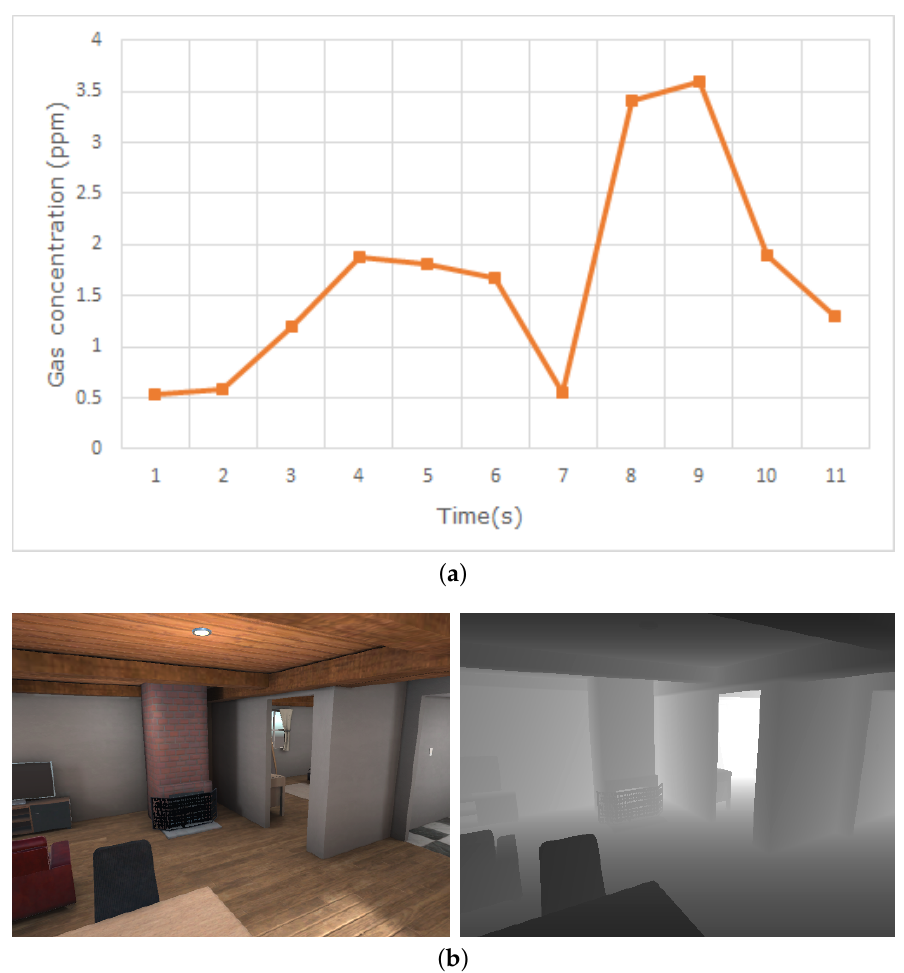
Figure 4. ( a ) Measurements obtained with a simulated photoionization detector at a given point over time. ( b ) RGB and depth images obtained from Unity’s simulated